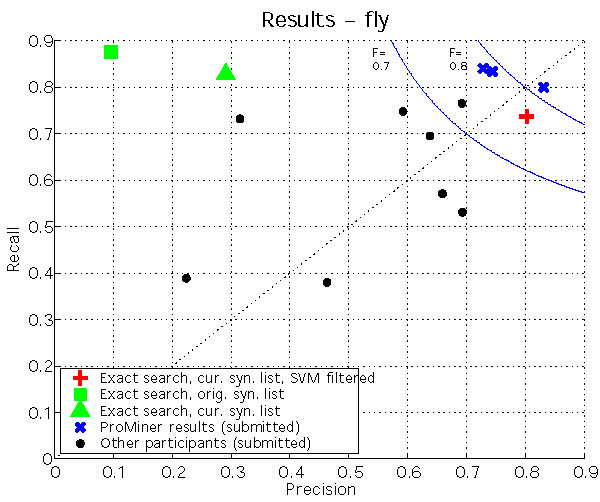
Fly results. Results for fly, obtained as post-evaluation of the BioCreAtIvE-assessment. The figure shows the results of exact matching of the synonym list as provided by the ProMiner-team (Exact search, orig. syn. list), exact matching of the curated synonym list and exact matching of the curated synonym list with subsequent application of the SVM-based post filter. All submitted ProMiner results were obtained with one synonym list, which we here refer to as 'original synonym list', but different parameter settings [12].